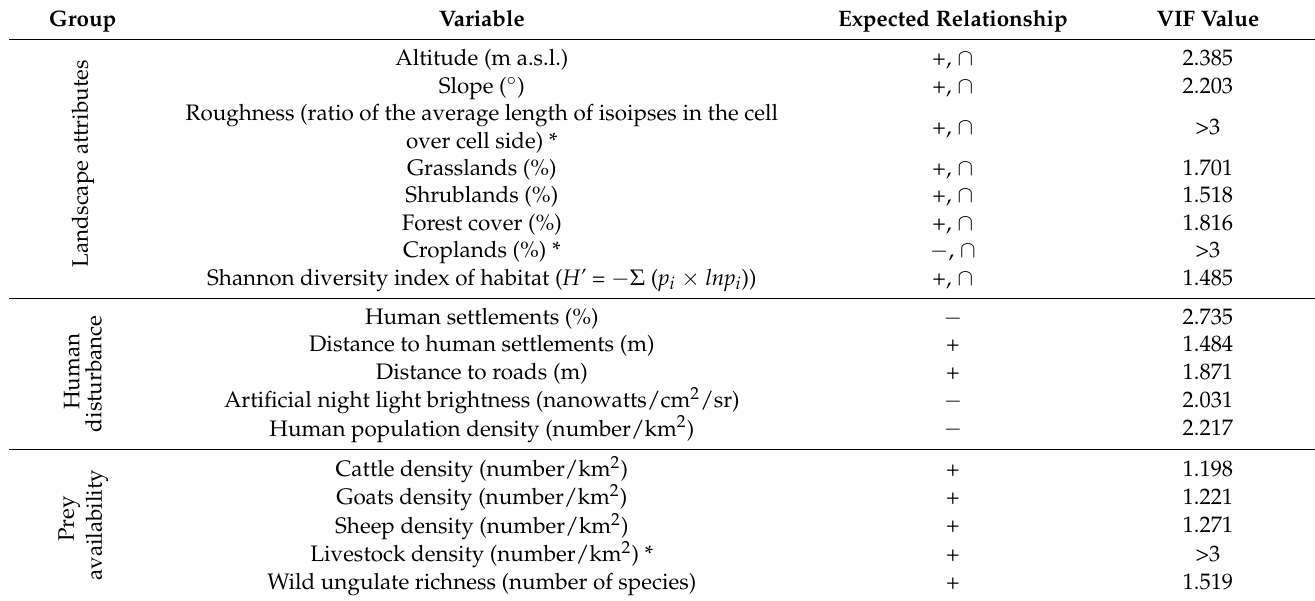
Table 1. Description of predictor variables, including the expected relationship with species occur- rence (positive (+), negative ( − ), hump-shaped ( ∩ )) and variance inflation factor (VIF) used to assess the degree of multicollinearity among the predictor variables. Variables with (VIF) > 3 were removed from further analysis